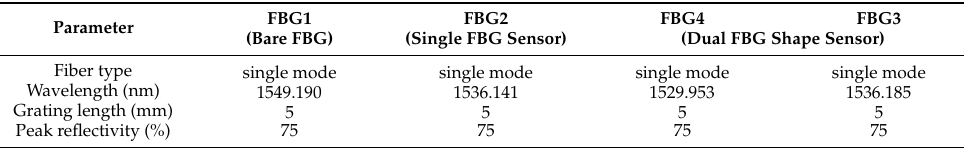
Table 8. The detailed parameters of the FBG